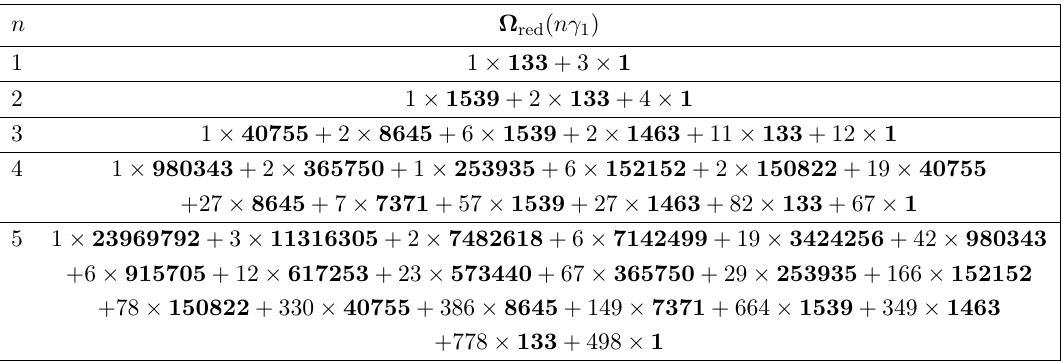
= p 2 + p 3 . (cid:6) (cid:6) (cid:6)